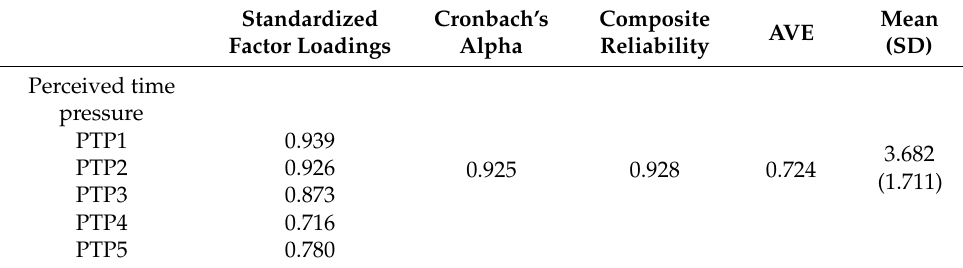
Table 2. Statistics of construct